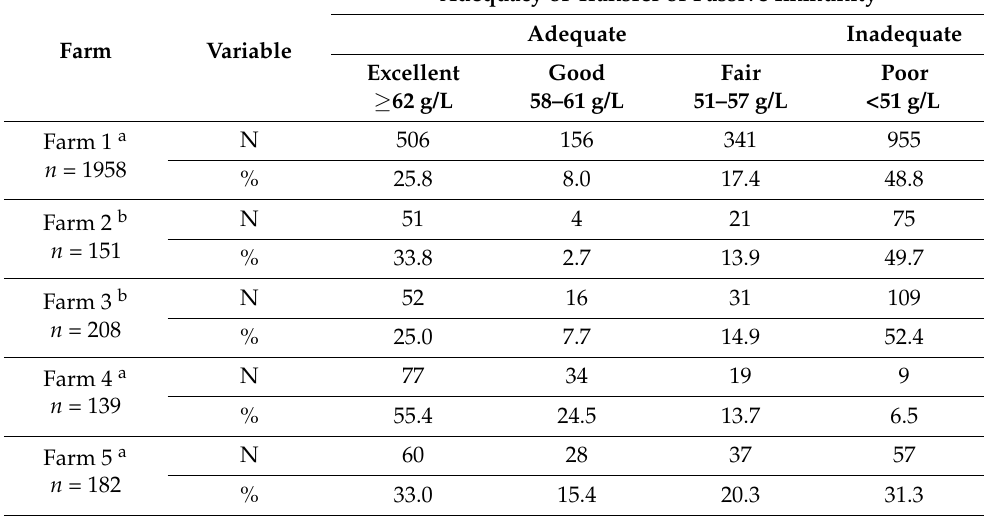
Table 4. Proportion of heifer calves, in excellent, good, fair and poor categories for transfer of passive immunity [17], from five dairy farms in South Australia. The transfer of passive immunity was estimated using serum